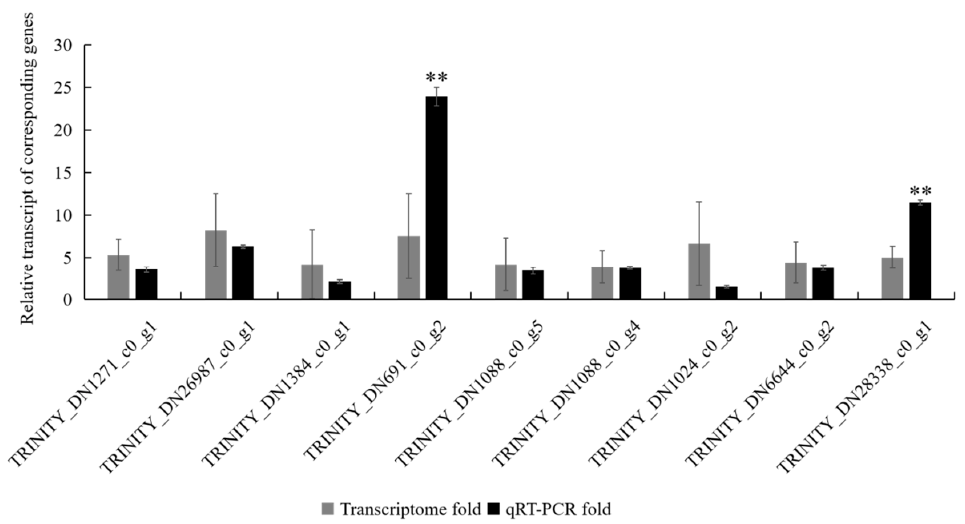
Figure 1. qRT-PCR validation of 9 selected DEGs associated with the immunity of H. cunea to confirm the expression pattern detected by sequencing. RPS16 gene was used as an internal reference gene. The qRT-PCR box represents the mean average of specific 2 −ΔΔ Ct values, the transcriptome box represents the log2FoldChange value of each DEG. All genes are shown in the Supplementary Material: Table S2. p < 0.01 (**) was considered very significant.